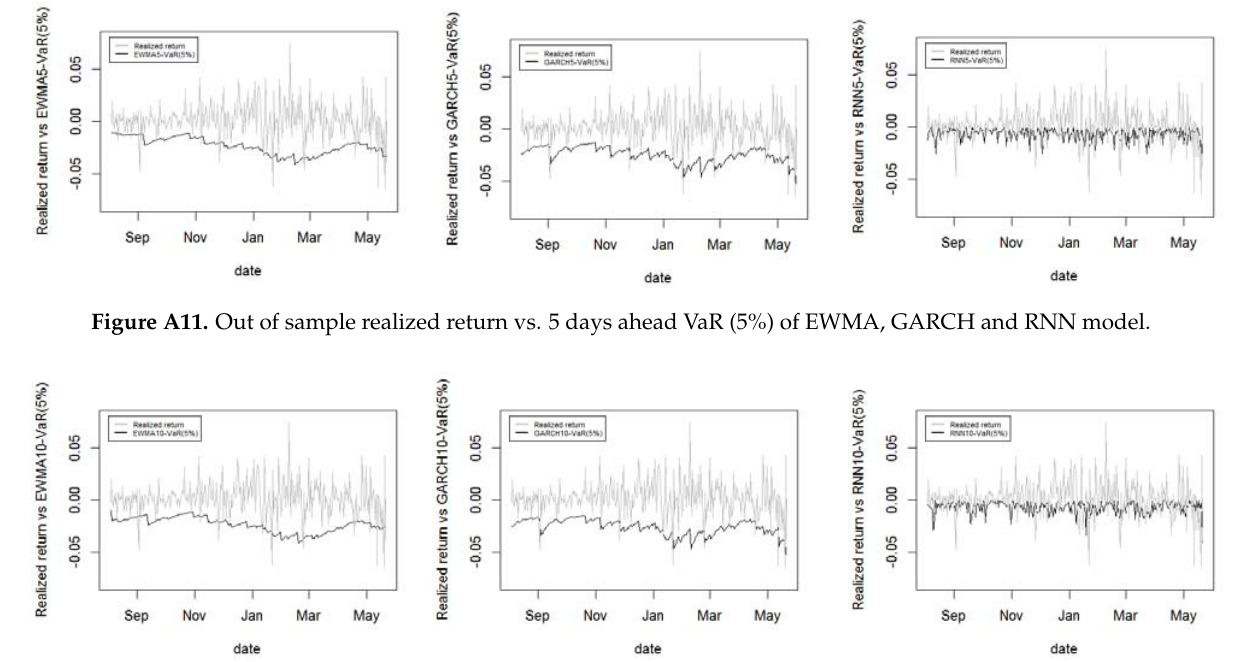
Figure A12. Out of sample realized return vs. 10 days ahead VaR (5%) of EWMA, GARCH and RNN model.